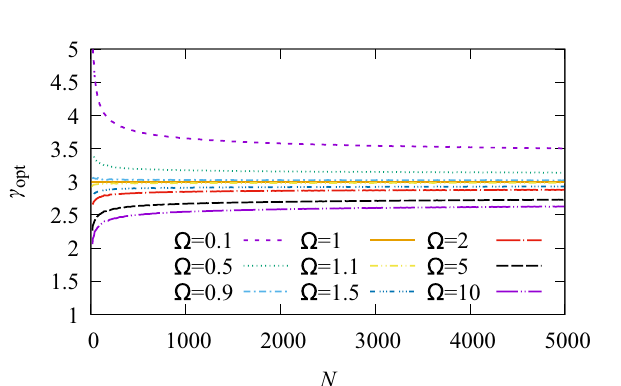
3 ) depend strongly on the metabolic ratio, (cid:31) , but are Figure 3. ( a ) Deviations from Murray’s law ( γ opt = essentially independent of the structure of the tree. The figure shows a comparison of γ opt vs (cid:31) for fully symmetric, asymmetric and numerical trees. ( b ) Optimal bifurcation exponent does not depend strongly on α .